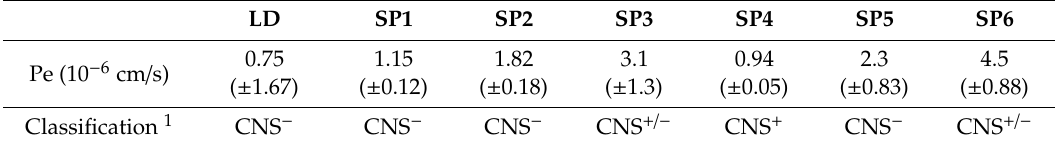
Table 2. Parallel artificial membrane permeability blood brain barrier (PAMPA-BBB) data of SP1–6. LD SP1 SP2